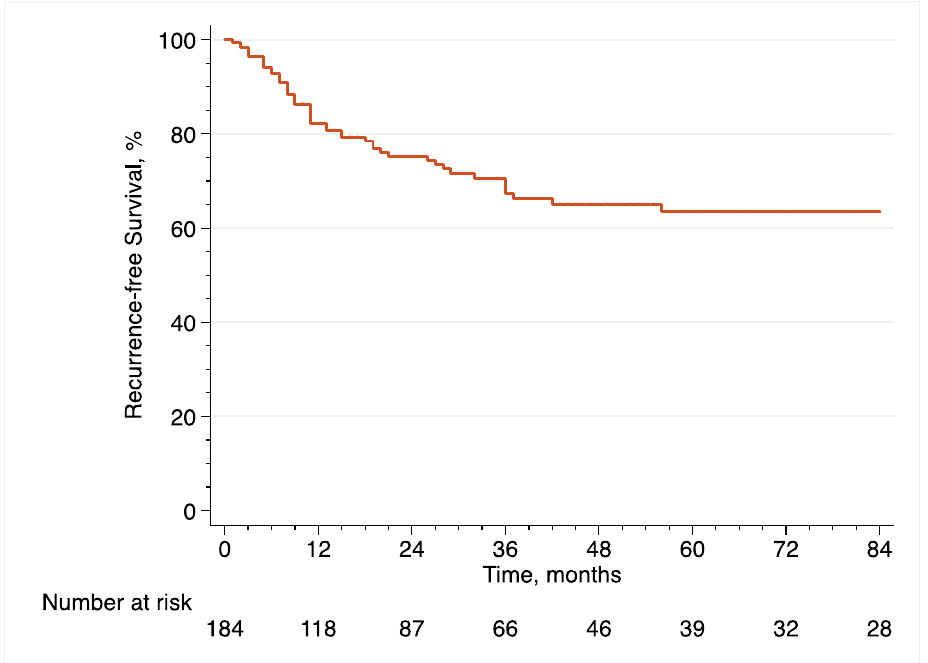
Figure 1. Kaplan–Meier curve that analyses the RFS of included patients treated with eRC for